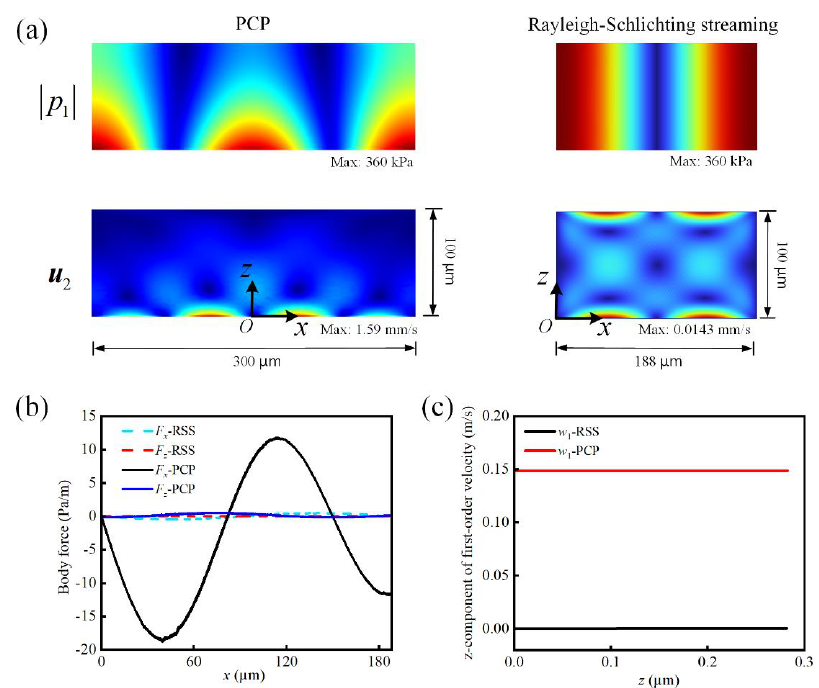
Figure 3. Comparison of the calculated ( a ) acoustic field and AS, ( b ) body force, and ( c ) z-component of the first-order acoustic velocity between the PCP and RSS.